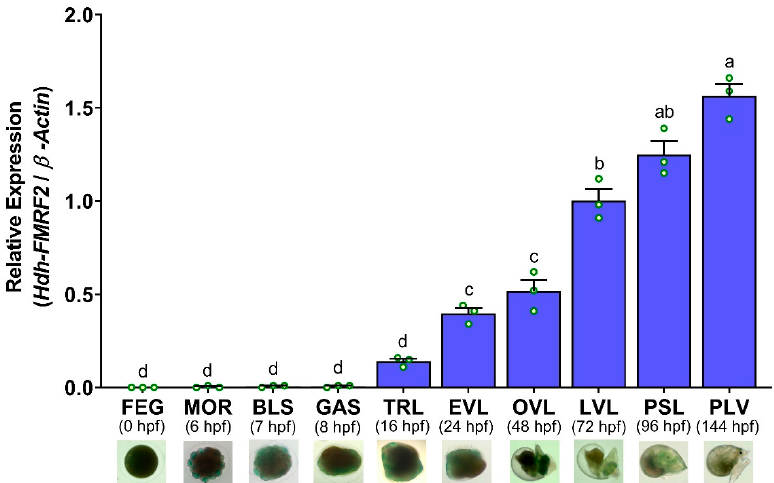
Figure 11. Changes in mRNA expression levels of Hdh-FMRF2 in different embryonic and larval developmental stages of Pacific abalone. For all bar graphs, the raw data points (green circle) represent biological replicates, the error bars represent the standard error of the mean (SEM), and different letters above the bars indicate significant differences ( p < 0.05) among different developmental stages. X -axis includes names of embryonic and larval development stages, hpf (hours post-fertilization, and microscopic image of each developmental stages. FEG, fertilized egg; MOR, morula;